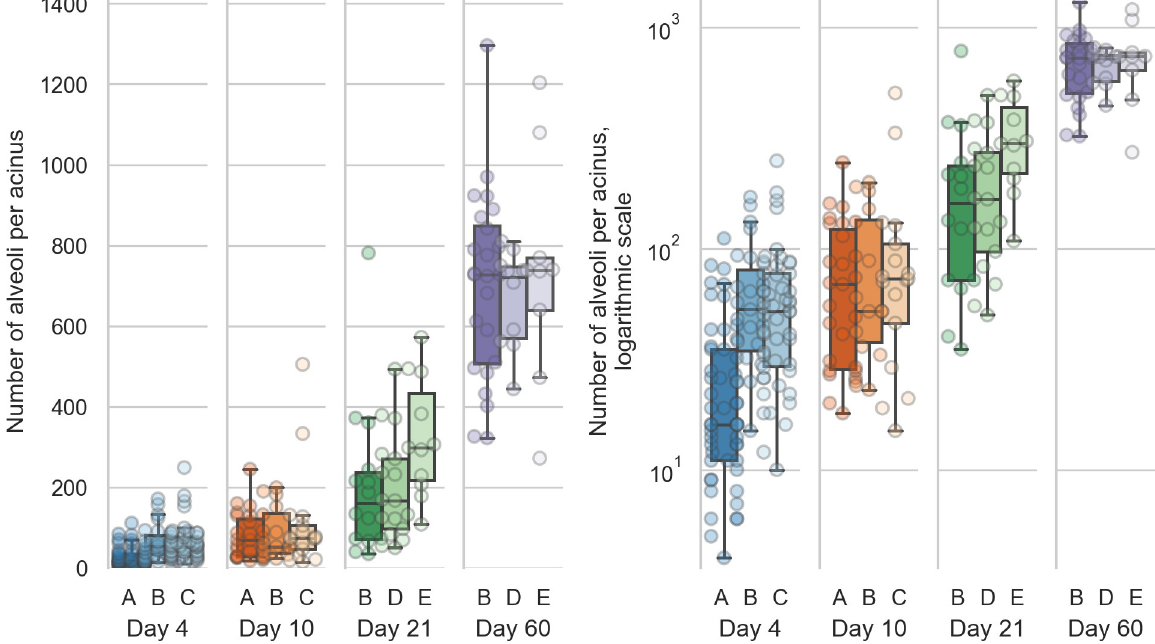
Fig 2. Distribution of the number of alveoli per acinus (entrance ring count per acinus) for each animal. Left: linear scale, right: logarithmic scale. The entrance ring counts per day are all significantly different (all p-values smaller than 1.9e-5, which is the p-value between days 4 and